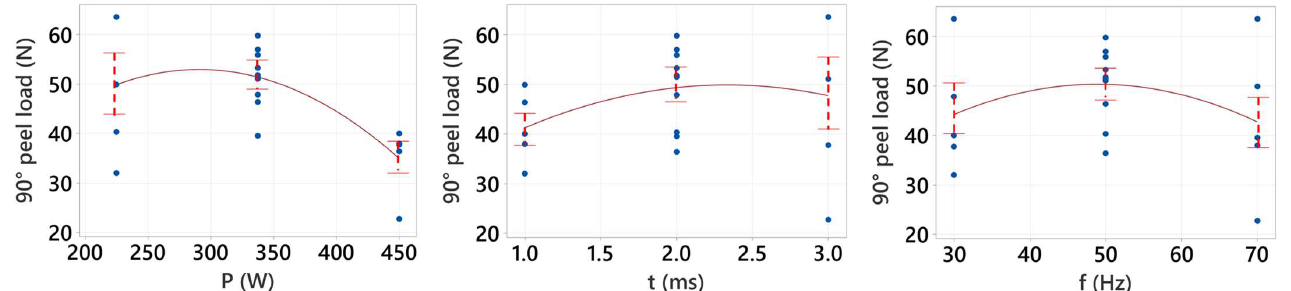
Figure 3. Main effects plot for means of 90° peel load.